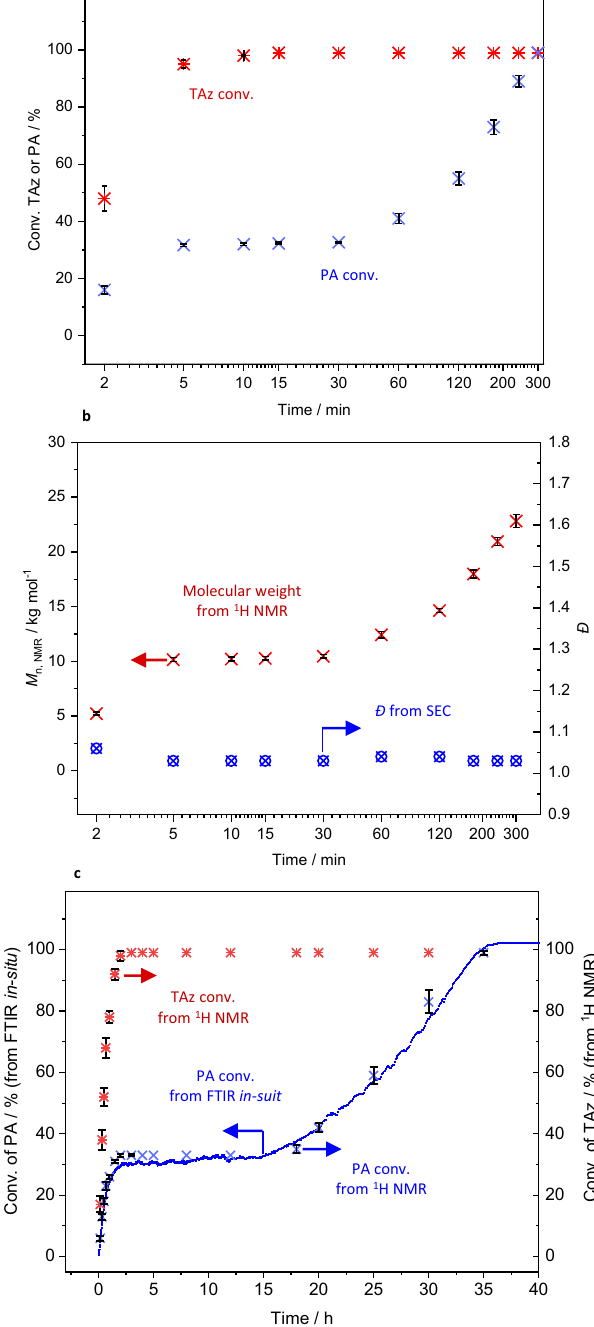
Fig. 6 Polymerization kinetic analysis. a Plots of monomer conversions versus time (100 °C) monitored by 1 H NMR spectroscopy. b M n, NMR and Ð versus time. c Plots of monomer conversions versus time (60 °C) monitored by 1 H NMR spectroscopy and in situ FTIR (error bars represent the standard